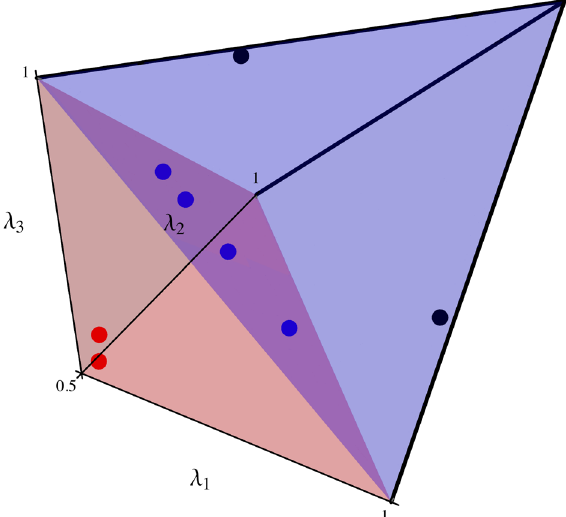
FIG. 3. Full polytope for three qubits. The blue region is the W polytope, while the light red one represents all the GHZ states that cannot contain the W kind of entanglement (see also Fig. 1). The blue, red, and black symbols represent, respectively, the W , GHZ , and BS states. The error bars are inside each point (see Appendix